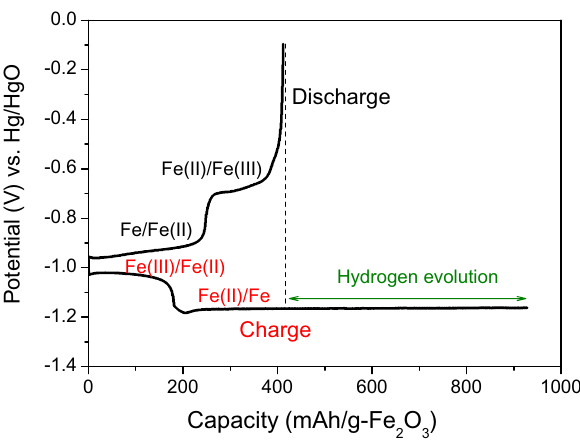
Figure 7. Charge–discharge curves of Fe 2 O 3 /AB electrode with cubic-shaped α-Fe 2 O 3 in KOH + K 2